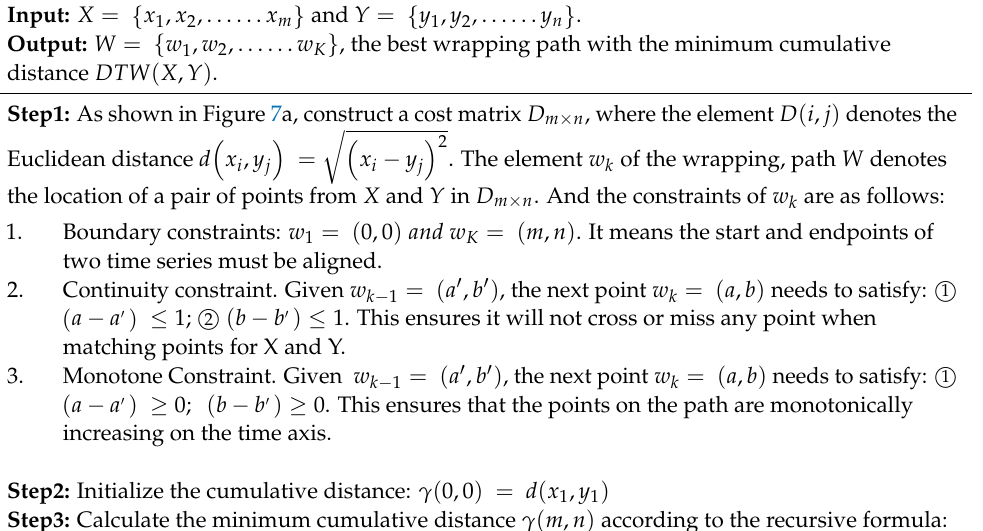
Algorithm 1. Dynamic time warping algorithm.